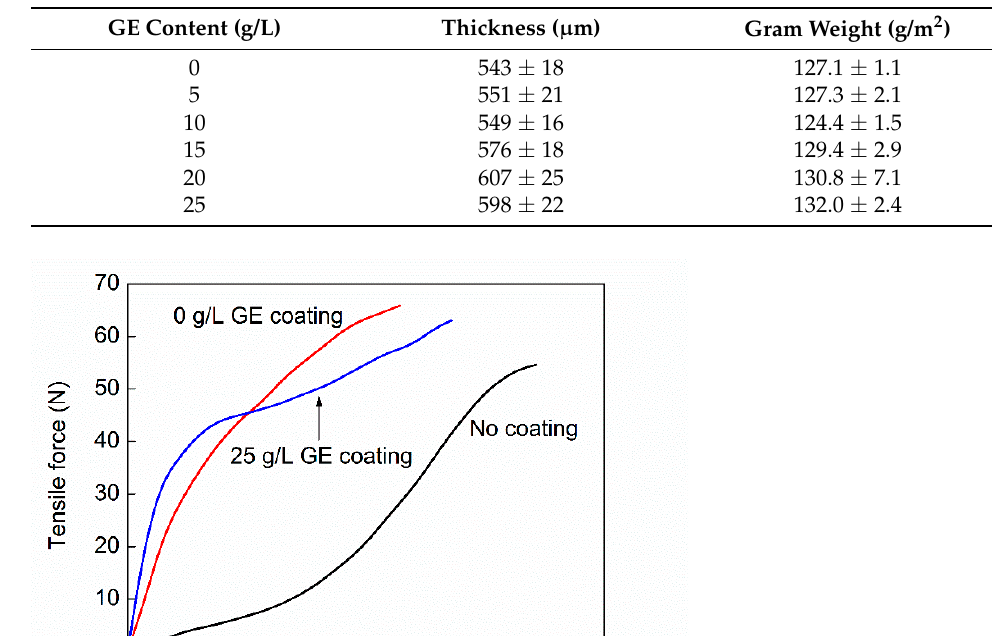
Table 3. Fundamental properties of composites with various coating agent GE content.